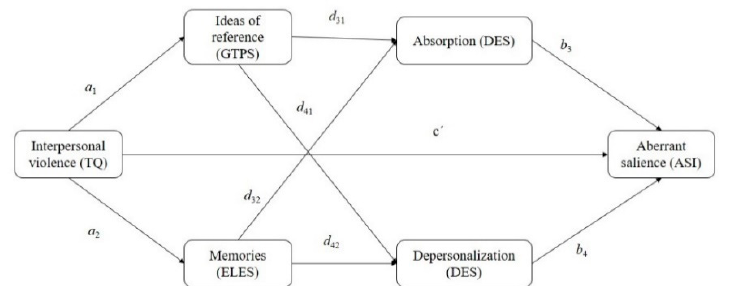
Figure 1. Path diagram of hypotheses 1 and 2; the conceptual model. Note: a 1 = path from Interpersonal Violence to Ideas of Reference; a 2 = path from Interpersonal Violence to Memories; d 31 = path from Ideas of Reference to Absorption; d 41 = Path from Ideas of Reference to Depersonalization; d 32 = path from Memories to Absorption; d 42 = Path from Memories to Depersonalization; b 3 = path from Absorption to Aberrant Salience; b 4 = path from Depersonalization to Aberrant Salience. C´ = direct effect of X on Y.